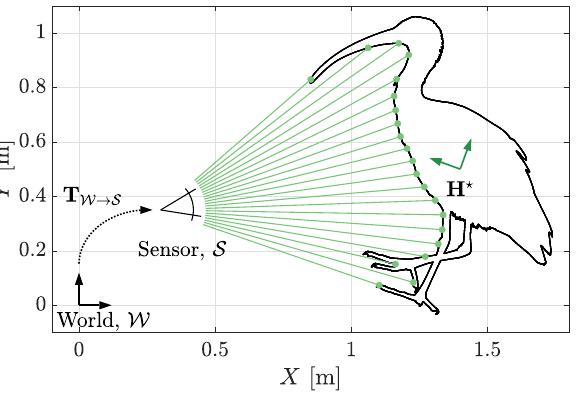
Figure 12. The maximum sum of evidence estimate, H (cid:63) , of a 2D shape’s pose. The pose solution that generated the maximum sum of evidence was determined to be H (cid:63) = [ 70.178 ◦ , 1.399 m, 0.501 m ] . Comparing H truth and H (cid:63) directly can be